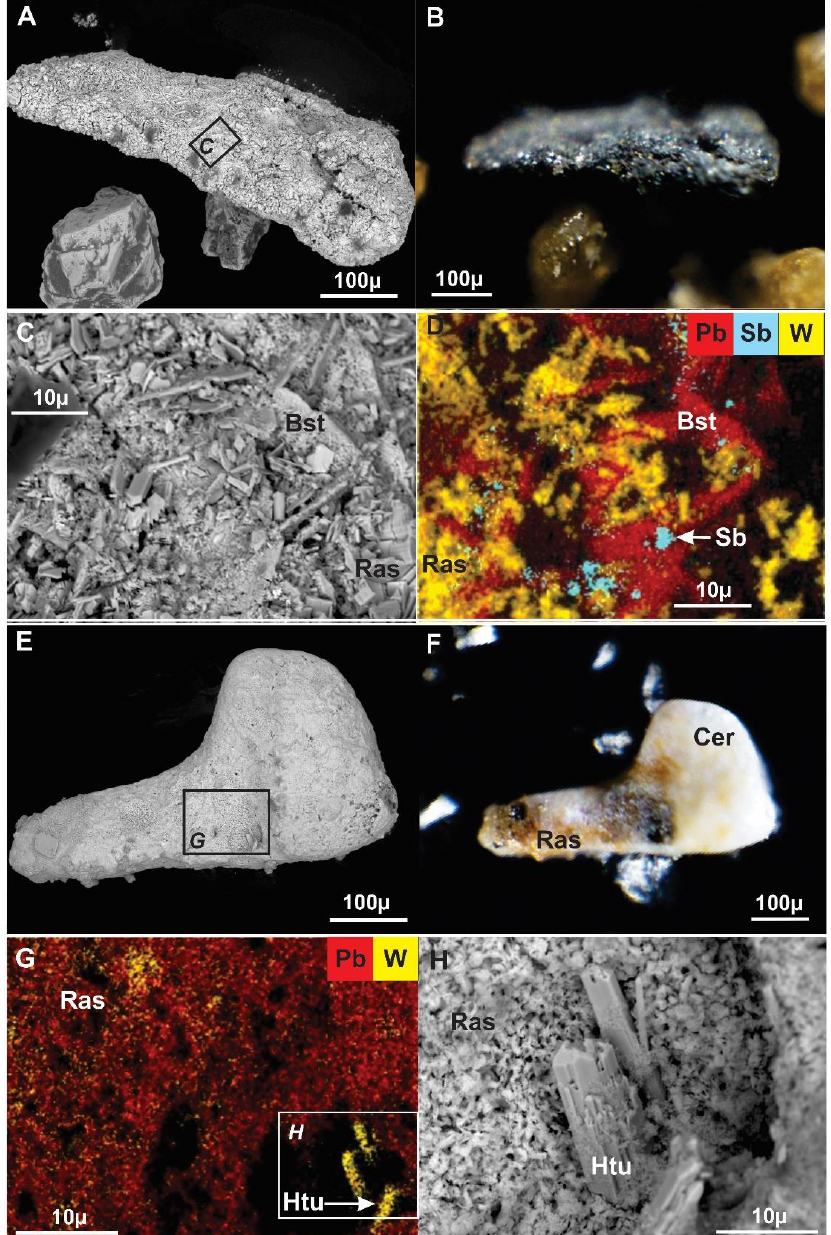
Figure 9. Composite Pb-W-Sb Grains. ( A ) BSE image of fibrous composite grain; ( B ) photograph of Grain ( A ); ( C ) BSE image of close-up on Grain ( A ) showing platy barstowite, bladed respite, and native Sb; ( D ) X-ray map of ( C ); ( E ) BSE image of cerussite grain with raspite on the surface; ( F ) photograph of Grain ( E ); ( G ) X-ray map of closeup of Grain ( E ); ( H ) X-ray map of closeup of image ( G ) showing bladed hydrotungstite. Bst: Barstowite; Sb: Native Antimony; Cer: Cerussite; Ras: Raspite; Htu: Hydrotungstite.